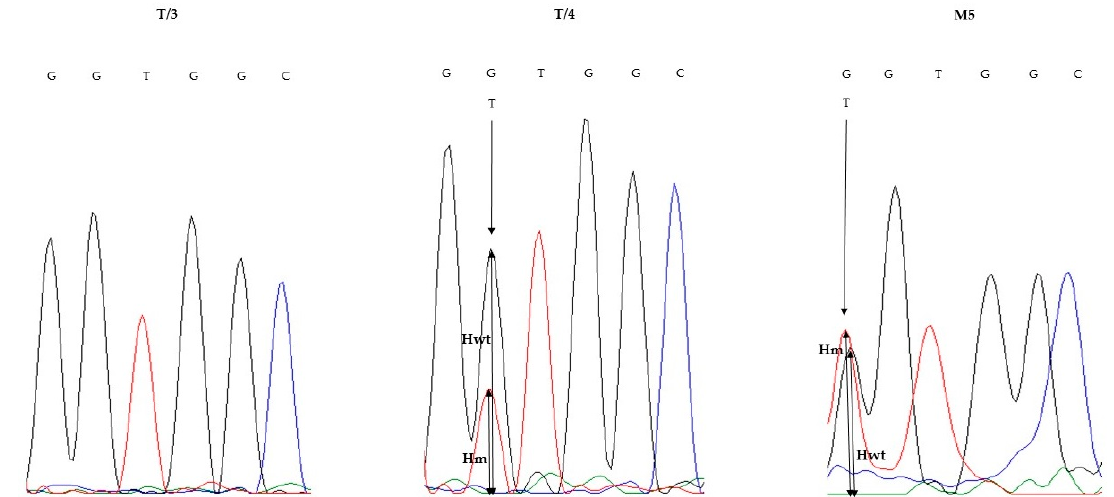
Figure 3. Direct sequencing (Sanger) electropherograms of codons 12 and 13 of the KRAS gene, demonstrating different codon 12 variants in primary tumor T/3 (wild-type, left), T/4 (c.35G > T; center) and in liver metastasis M5 (c.34G > T; right). Although T/3 proved to be KRAS wild-type by Sanger sequencing, low-frequency c.34G > T genotype could be safely presented using high-sensitivity NGS and StripAssay technologies. One-way arrows represent the site of the mutations and two-way arrows show the high of the waves. Hm = height of the mutant allele wave, Hwt = height of the wild-type allele wave, black wave: guanine (G), red wave: timin (T) and blue wave: cytosine (C).